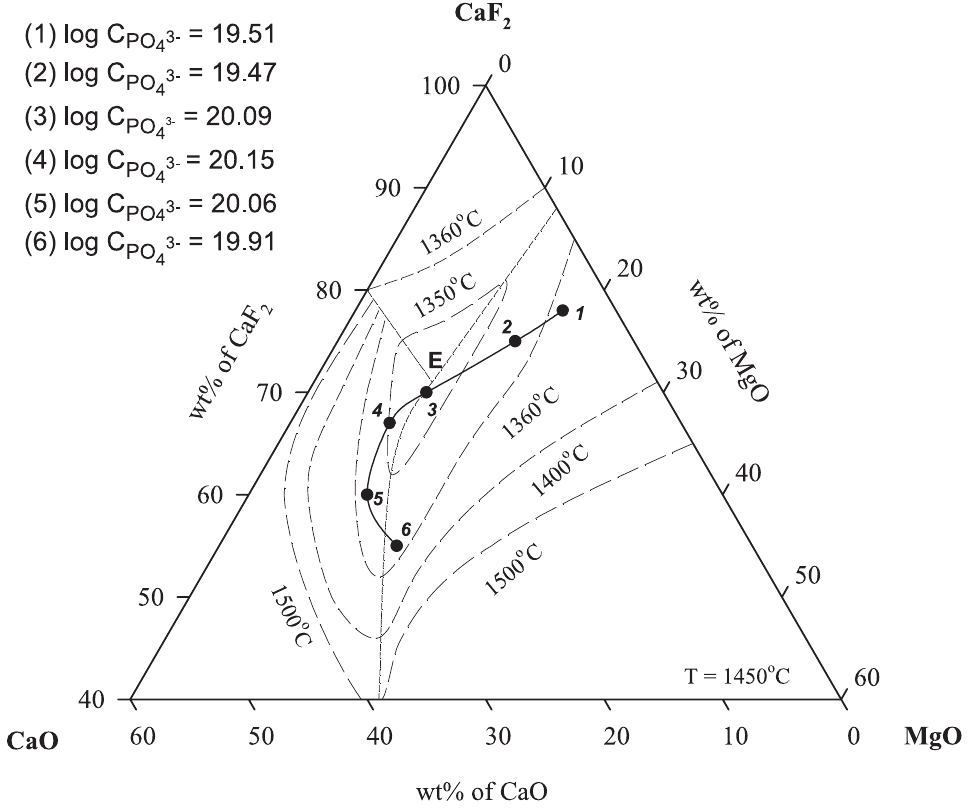
Fig. 3: Variation of the phosphate capacity of the CaO-MgO-CaF 2 system at 1450 °C. The ternary phase diagram was adapted from reference